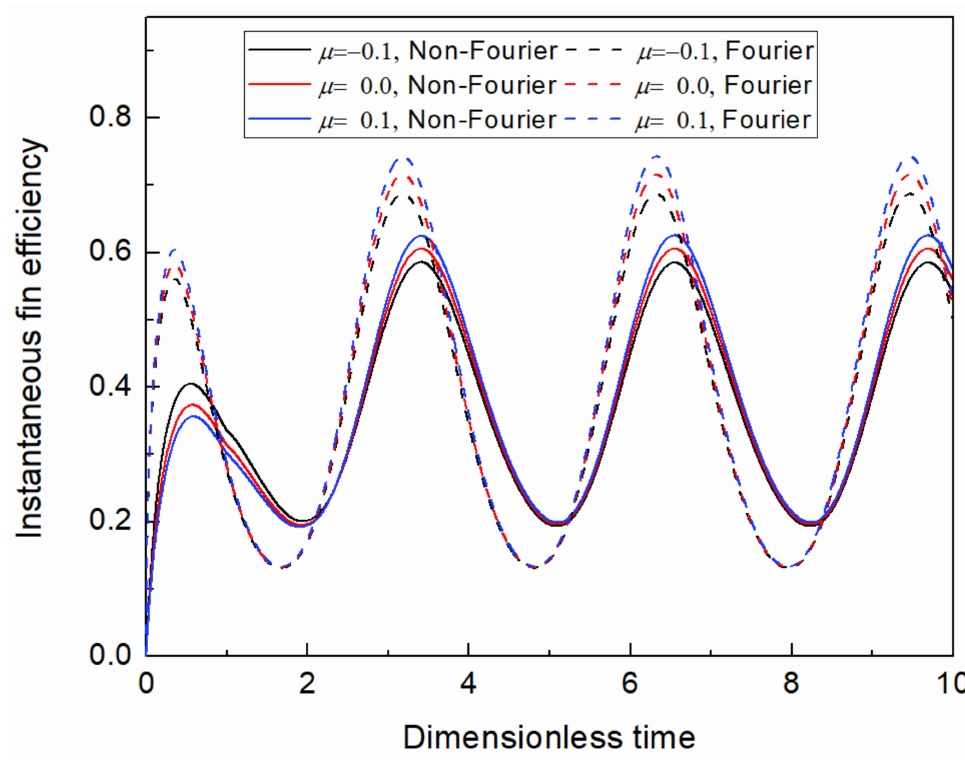
Figure 11. The variation of instantaneous fin efficiency at different values of µ .